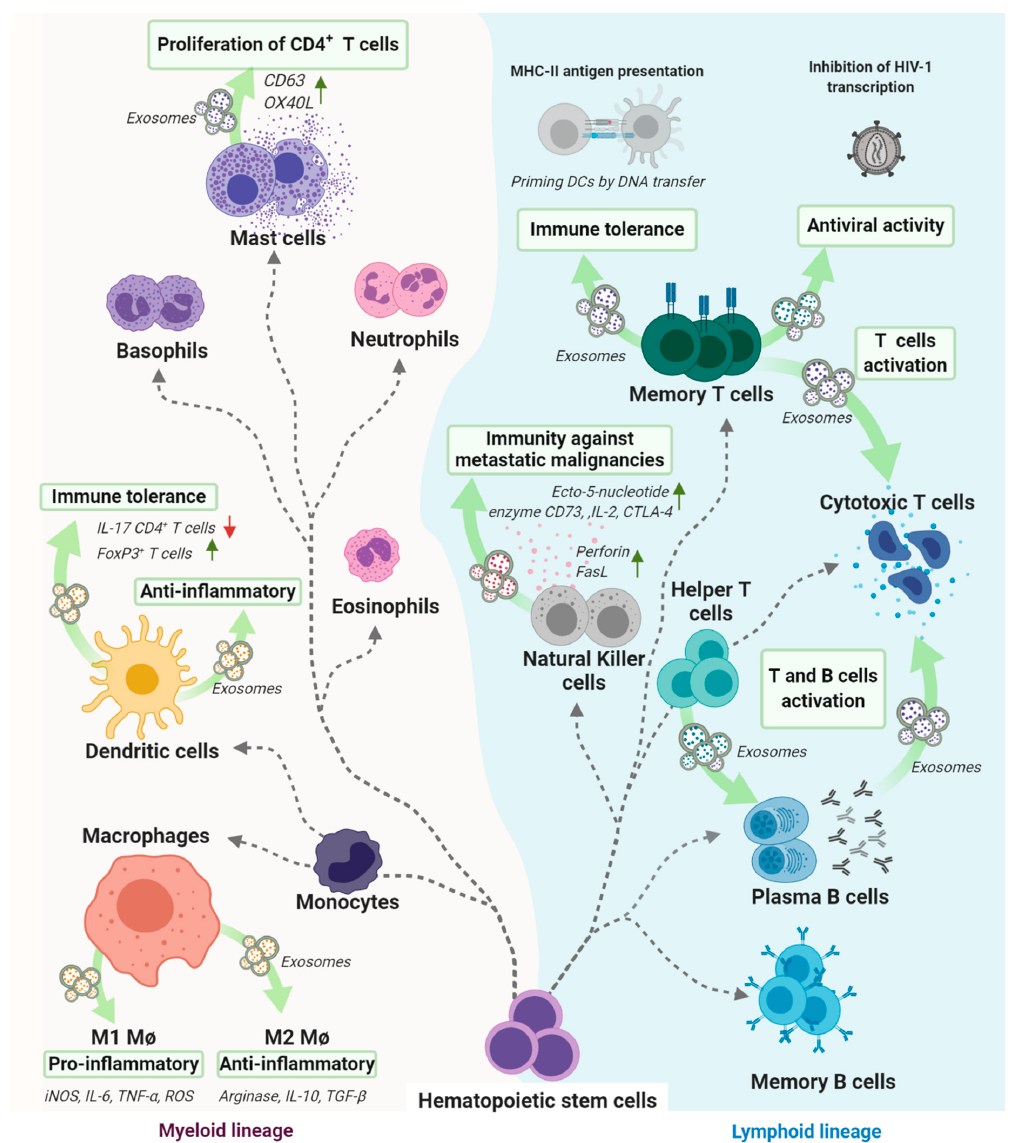
Figure 2. Secretion of exosomes associated with immune cells types and their modes of action.